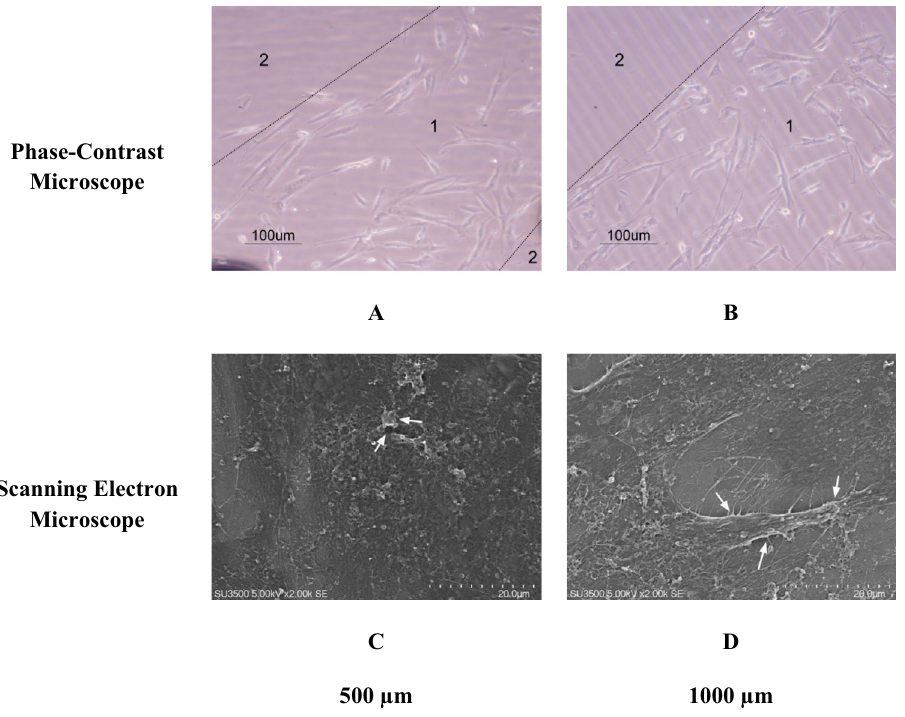
Figure 4. hWJ-MSCs morphology on micropattern surface 500 µm ( A , C ) and 1000 µm ( B , D ) fibronectin micropattern using µCP. The number represented fibronectin-coated area (1) and uncoated area (2), white arrow showed cytoplasmic protrusion.